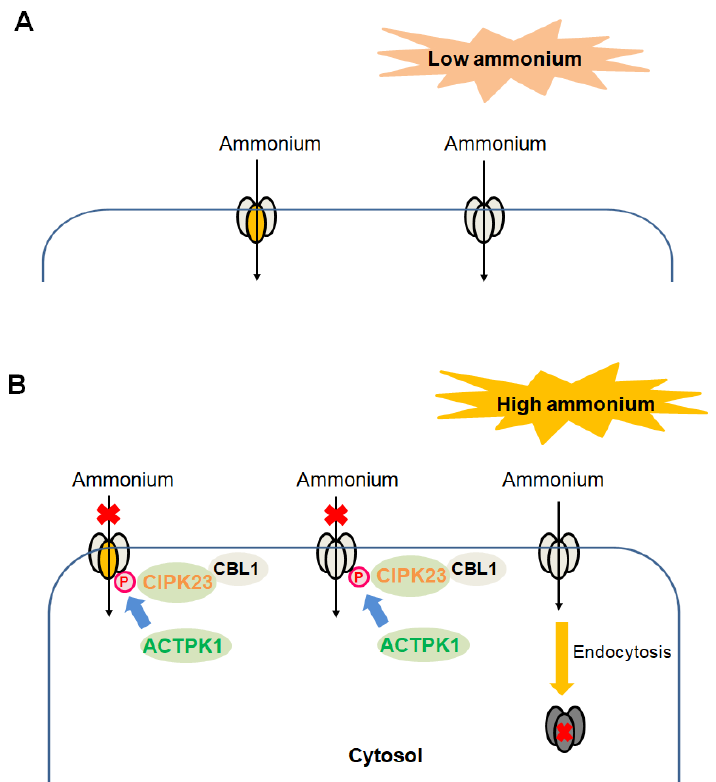
Figure 1. Functional regulations of plant AMTs at the protein level in cells. ( A , B ), Regulatory strategies used by plant AMTs upon either the exposure to low concentrations of ammonium ( A ) or the high concentrations of ammonium ( B ). When subjected to low concentrations of ammonium, AMTs in the homotrimer form (same-colored ellipses) or the heterotrimerization form (di ff erent-colored ellipses) are active ammonium transporters, mediating the uptake of ammonium into the cytosol. When exposed to high concentrations of ammonium, the CBL1–CIPK23 protein kinase complex as well as the protein kinase ACTPK1 phosphorylates the carboxyl terminus of AMTs, resulting in functional shut-o ff . Once a single monomer among the homotrimer (same-colored ellipses) or the heterotrimerization (di ff erent-colored ellipses) is phosphorylated, the AMT is inactive overall. Additionally, the quantities of plasma-membrane-located AMTs are decreased through clustering and endocytosis into the cytoplasm. Both cases reduce the ammonium influx across the plasma membrane, preventing ammonium toxicity. However, upon shifting of plant cells from high ammonium exposure to the low ammonium condition thatrequiresAMTstoexertammoniuminflux, theprocessesforthede-phosphorylation(byphosphatase) of AMTs to re-enable them as functional ammonium transporters and for the re-tra ffi cking of AMTs to the plasma membrane to facilitate transport remain to be